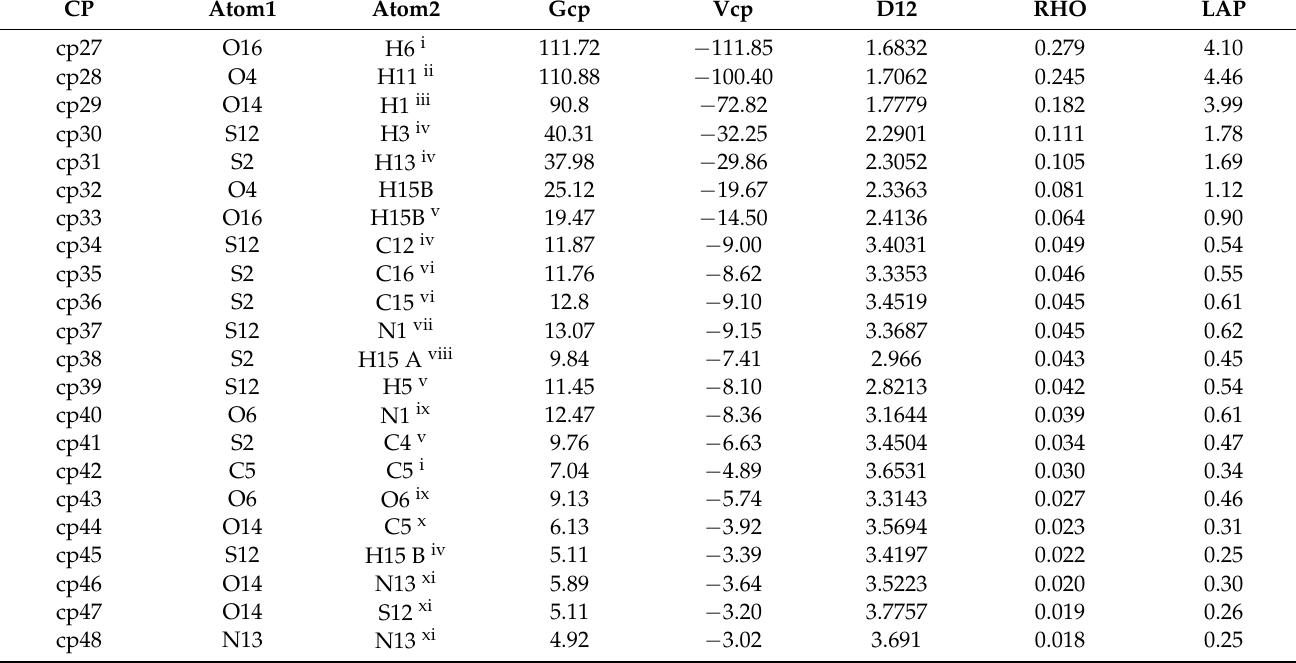
Table 4. Selected characteristics of intermolecular BCP for TBA molecules. D12: distance between